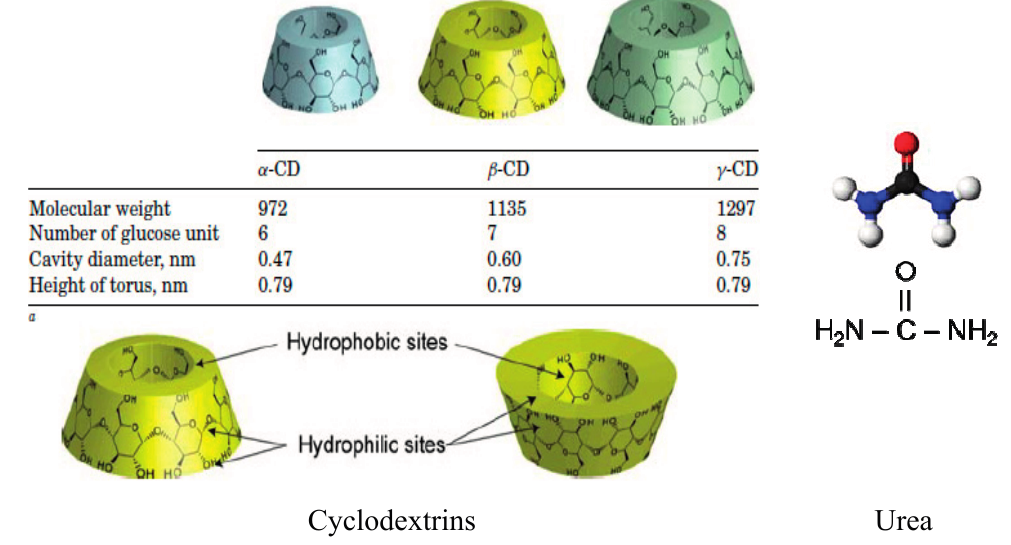
Figure 1. Cyclodextrin (CD) and Urea (U) hosts used for forming polymer-inclusion compounds